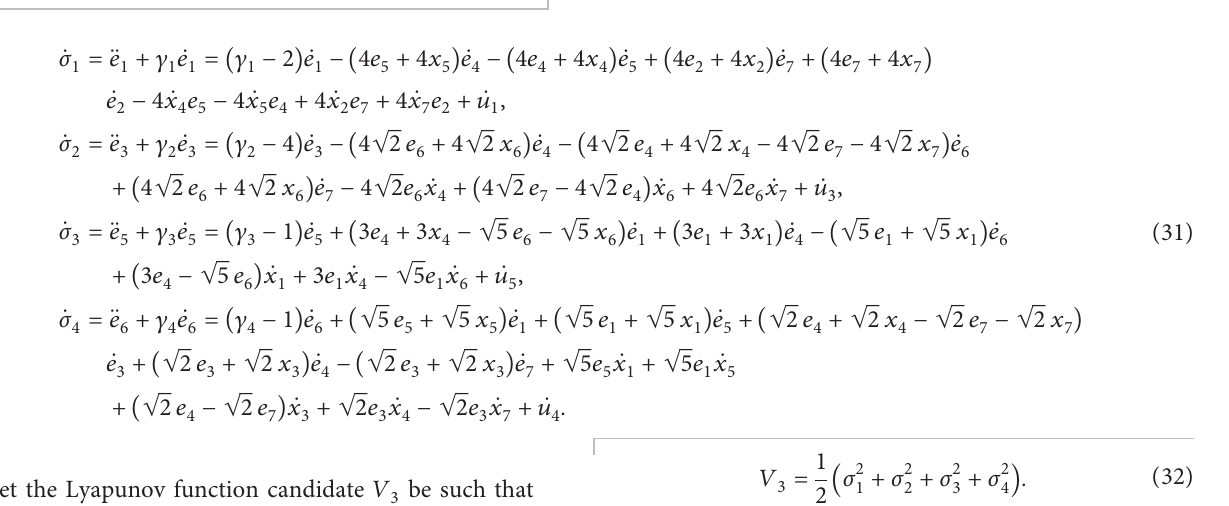
Figure 13: A dynamic sliding mode control of a stable periodic regime at the Reynolds number R symmetrized stable periodic state regime at R e � 24 in the master system (7). The controller is switched on at time t � 10. (a) The L ( t ) and y ( t ) versus time. (c) The states x the error e versus time. (b) The states x 1 1 ( t ) and y ( t ) showing how the controller drives the states from one attractor to another versus x 1 1